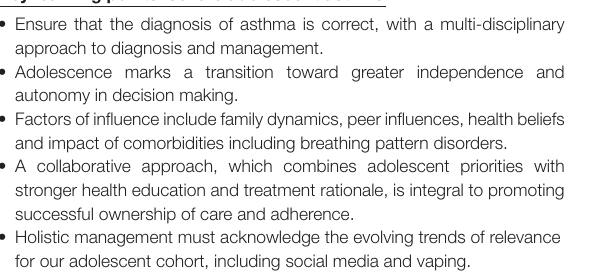
TABLE 1 | Summary of key learning